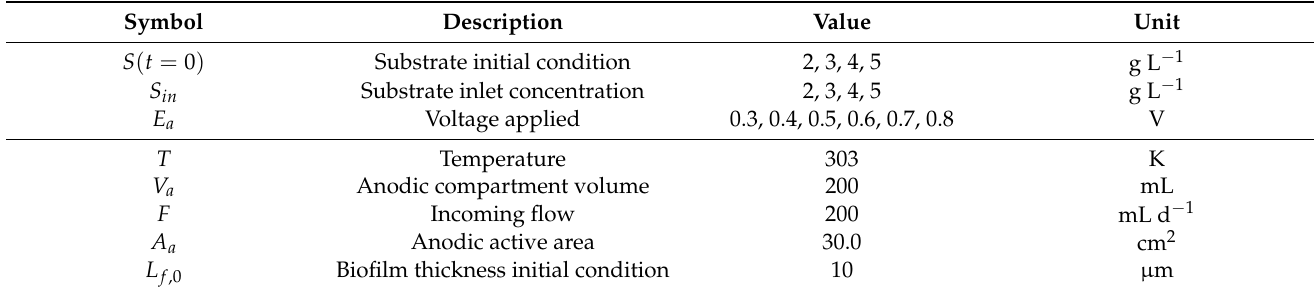
Table 4. Set of operating conditions and initial